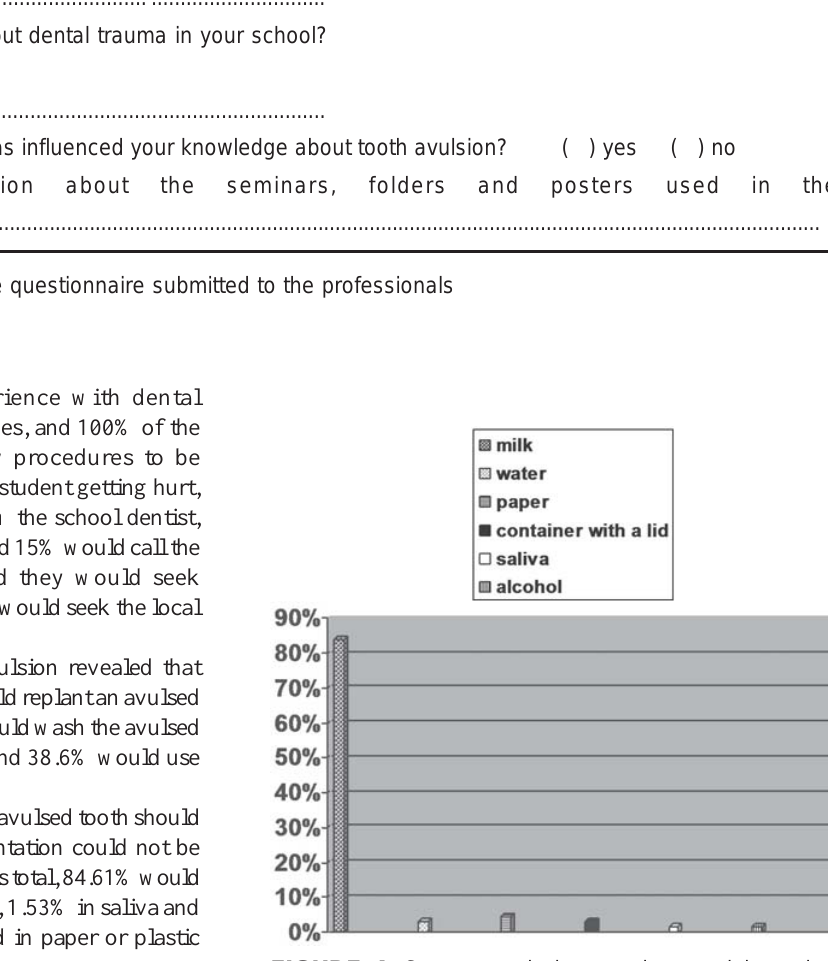
FIGURE 4- Storage solutions to be used by